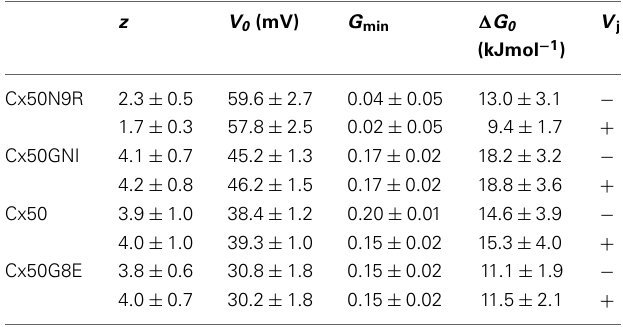
Table 1 | Boltzmann parameters and Gibb’s free